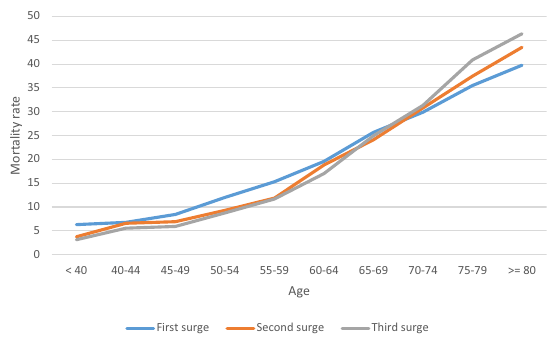
Fig. 1 In-hospital mortality by age during each surge of COVID-19. Blue, orange, and gray lines represent age-related mortality rate during the first, second, and third surges, respectively. The mortality rate was higher in people under 70 in the first wave than in the second and third waves. Conversely, the mortality rate increased from wave to wave in patients aged 70 and